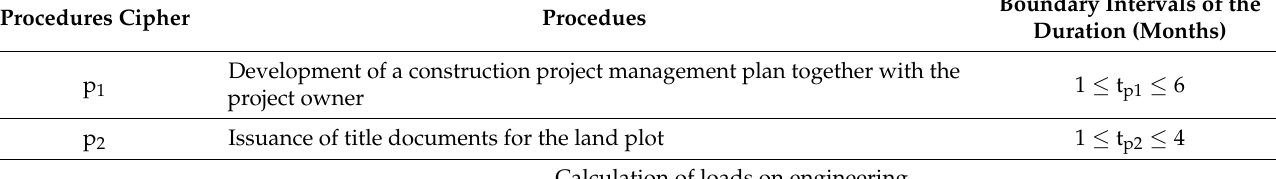
Table 1. Boundary intervals for the duration of procedures at the stages of pre-project preparation and design development for the facilities to be